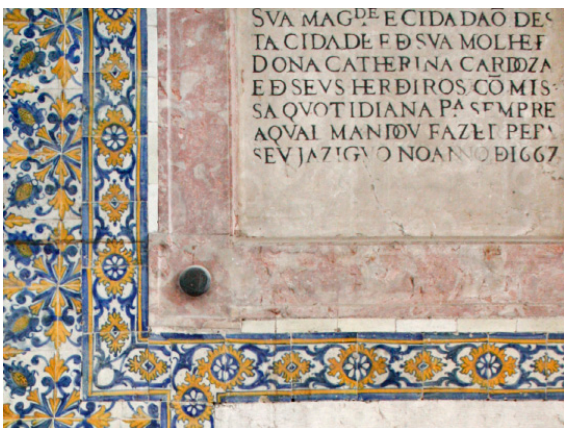
FIGURE 3 | Chapel of Cristóvão Fernandes da Rocha. Detail of the frames and of the white frieze used with the tombstone.